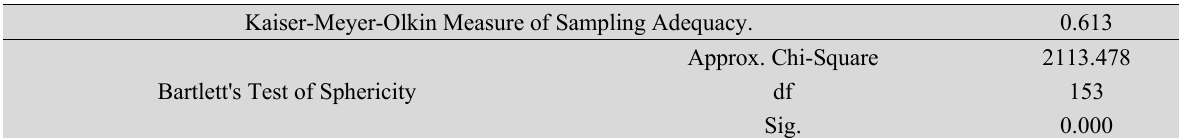
KMO and Bartlett's Test for VFM factors Kaiser-Meyer-Olkin Measure of Sampling